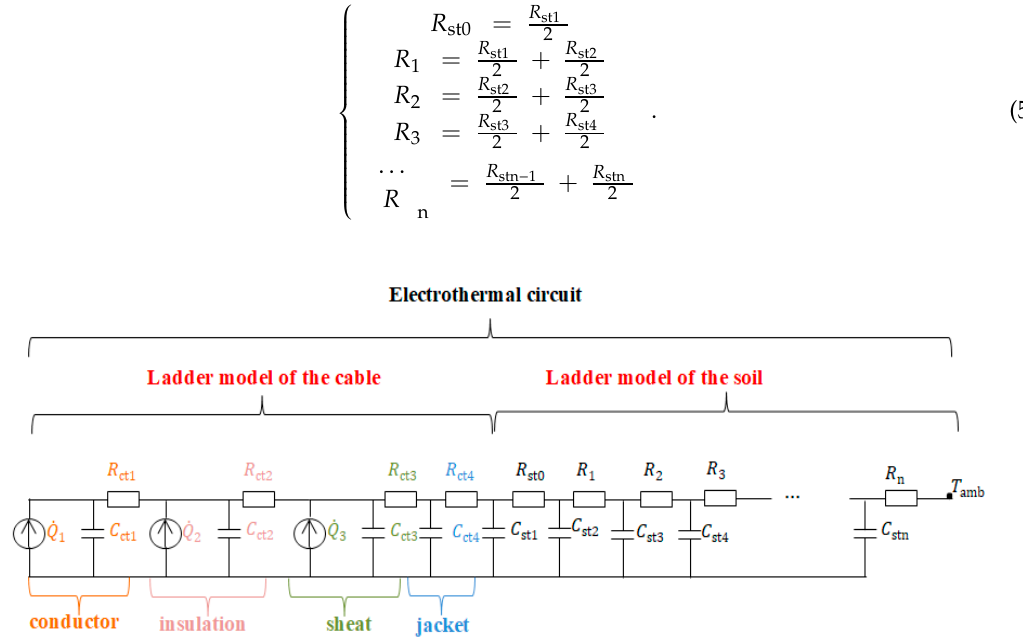
Figure 9. The lumped thermal parameter network of a buried cable and the soil.